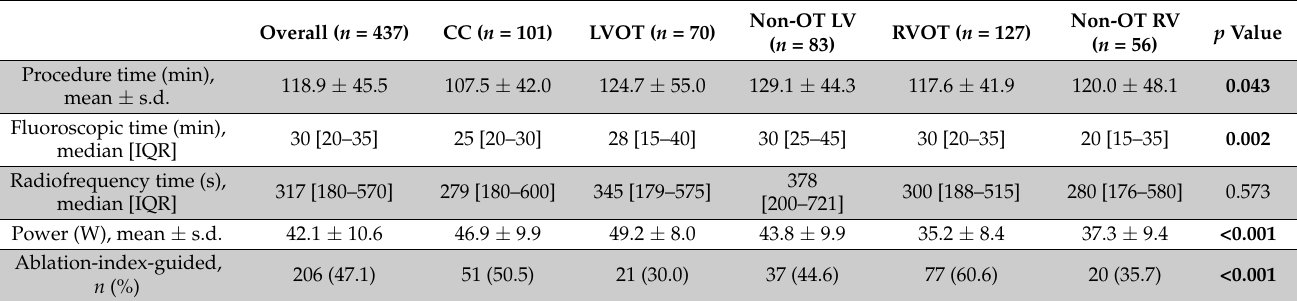
Table 2. Procedural